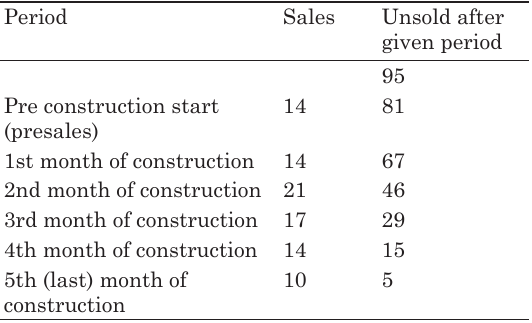
table 1. Case example. sales relative